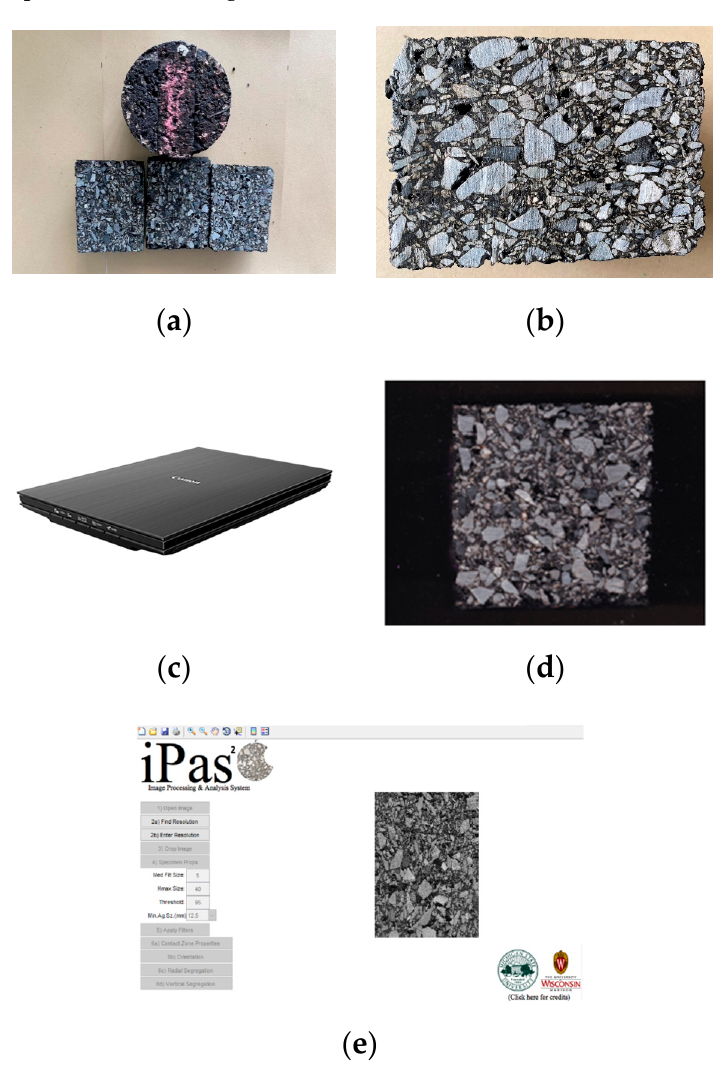
Figure 3. ( a ) Prepare the sample; ( b ) divide the sample into three pieces; ( c ) use a scanner to capture an image of the sample; ( d ) adjust the image by cropping it to prepare for input into image pro- cessing and analysis software; ( e ) analyze the sample using